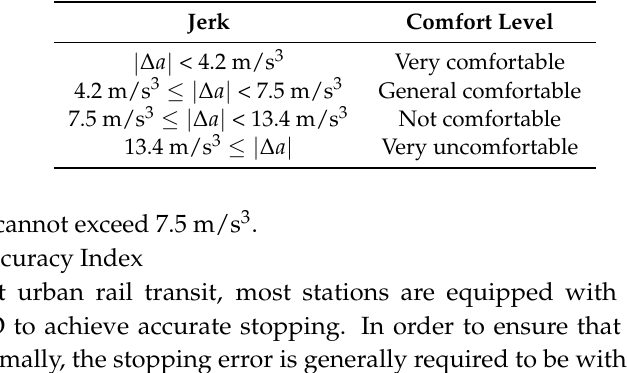
Table 1. The comfort